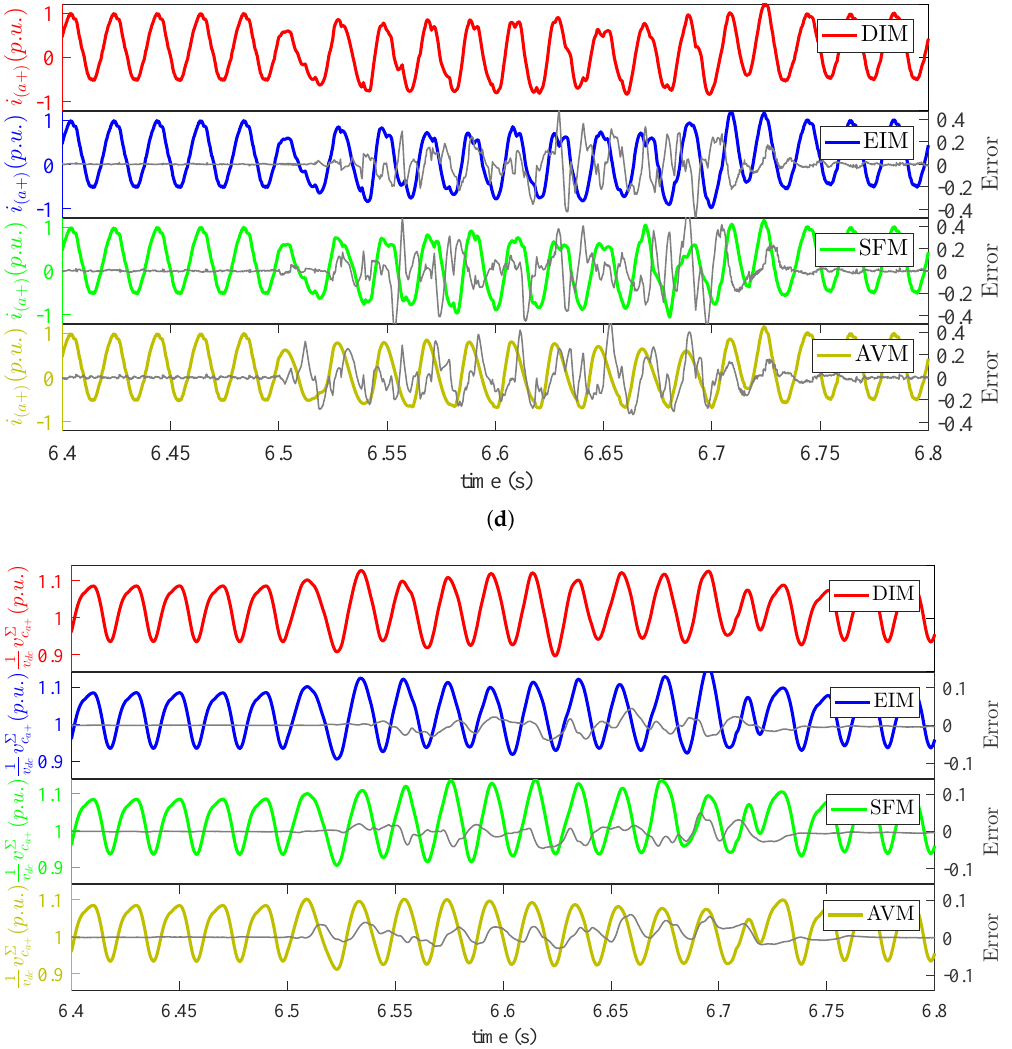
Figure 11. Three phase to ground fault. ( a ) AC voltage v ac the model error; ( c ) DC current i dc and the model error; ( d ) positive arm current i ( a +) and the model error; ( e ) cumulative capacitor voltage v